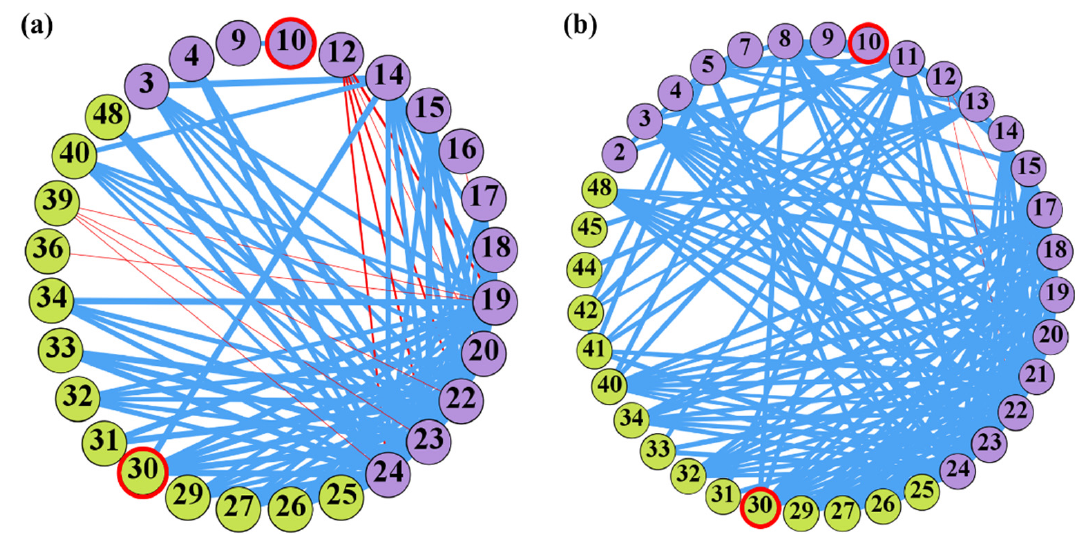
Figure 6. The example of CB networks for all cities ( a ) and coastal cities ( b ). TPF indicators are marked with a purple circle, while CBF indicators are marked with a green circle. Node #10 is the ‘groundwater scarcity’ indicator, and node #30 is the groundwater quality indicator (marked with a red circle). Blue-colored edges indicate positive weights while red indicates negative. The thickness of an edge is proportional to the absolute value of a weight.